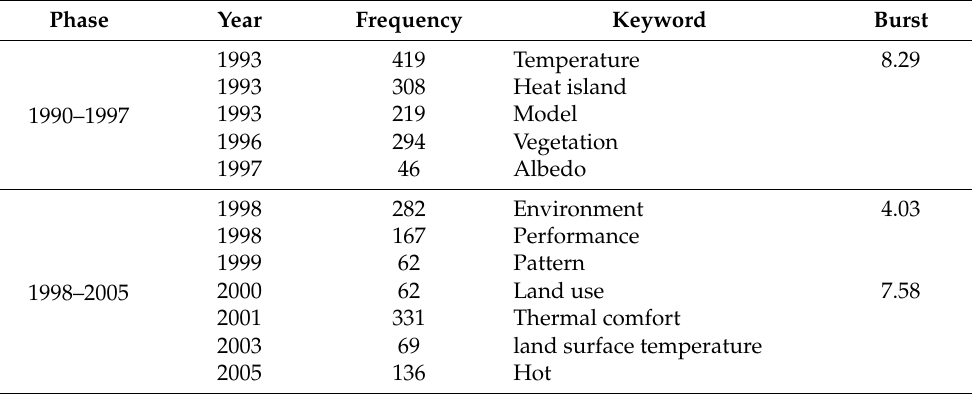
Figure 5. Temporal partition mapping of urban microclimate research keywords. Table 1. A burst of high-frequency keywords in urban microclimate research.